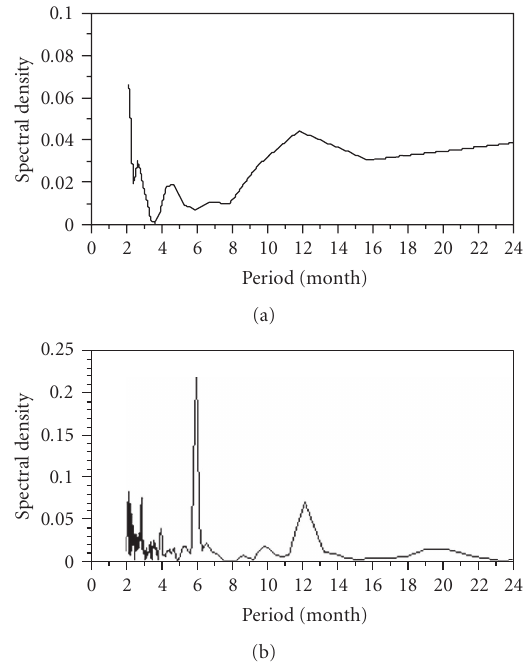
Figure 4: The spectral density plots for R of smallpox . The spectral density plots for the estimated reproduction numbers of smallpox in (a) the entire Netherlands, 1870–1873 and (b) Northwest frontier province, India, 1890–1921. Compared with Figures 2(d) and 2(e), the spectral densities clearly indicate a sharp peak at a period of 12